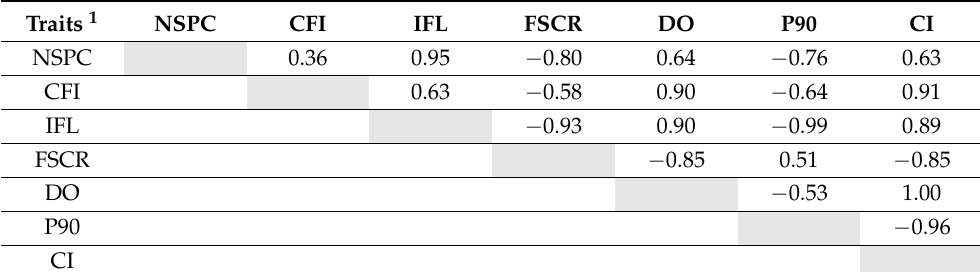
Table 2. Genetic correlations within reproductive traits in Thai–Holstein crossbred cattle. Traits